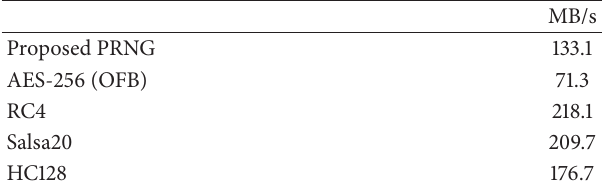
Table 4: Performance